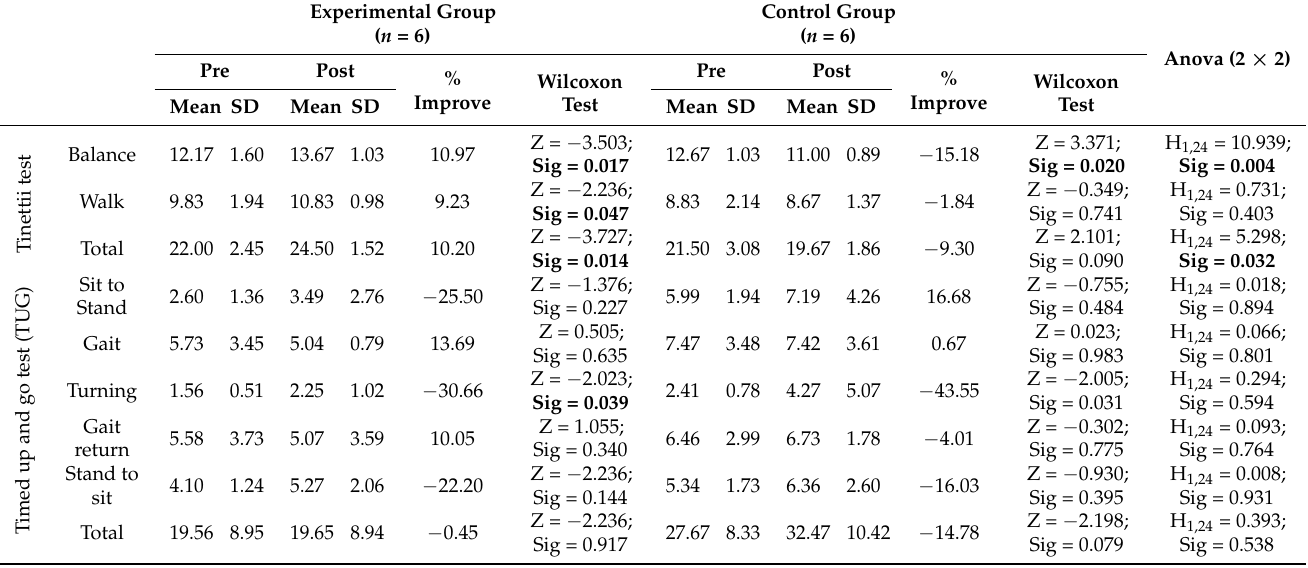
Table 2. Balance scores (static and dynamic metrics) in the sample.